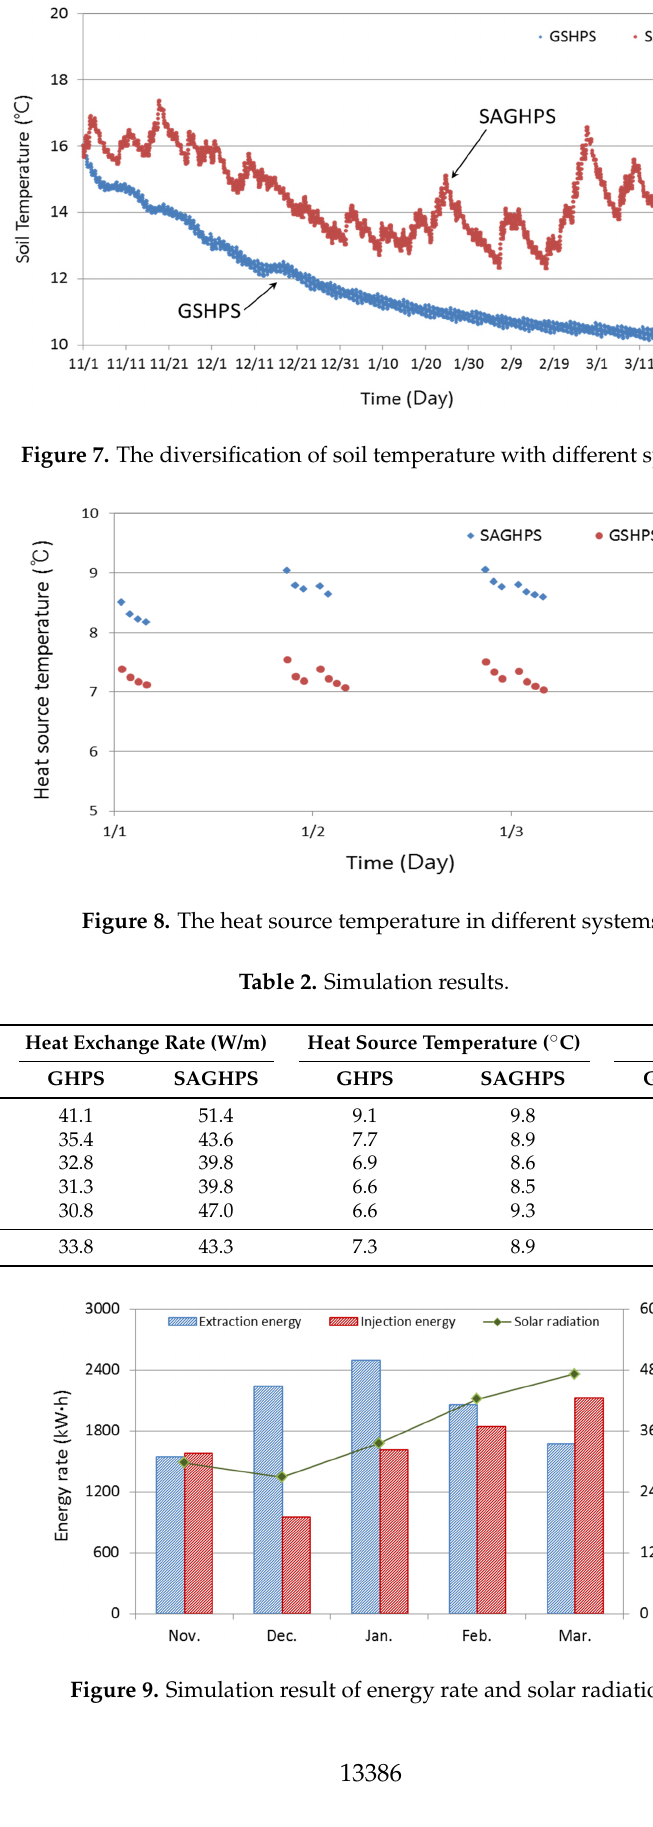
Figure 10. Difference of performance value between the two systems. 4.2. Performance Analysis with Different Solar Collector Areas In this section, the performance of SAGHPS is analyzed with a different solar collector area. The simulation results are shown in Table 3. With the increase of the collector area, more solar energy is absorbed. Therefore, as seen in Table 3, when the collector area is 90 m 2 , the injection energy to the ground is 12,164.9 kW ∙ h, which is 78.1% higher than that when the collector area is 50 m 2 . In addition, because of the high soil temperature, all performance values increased. However, Figure 11 shows that with the increase of the collector area, the solar storage ratio reduces. This means that, with the increase of the collector area, more absorbed solar energy flows away during the whole operation. The solar storage ratio can be calculated as follows: η = (cid:3018) injection (cid:3018) solar (9) Table 3. Simulation results with different collector area. Case